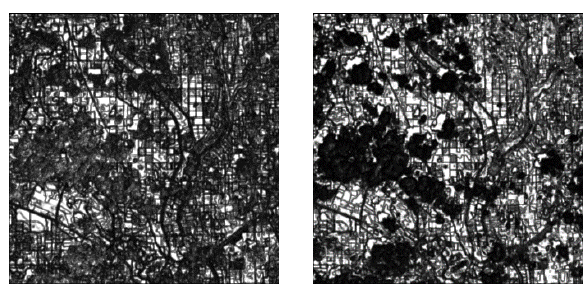
Figure 2 . Hotelling transformation results correspond to the two largest eigenvalues.